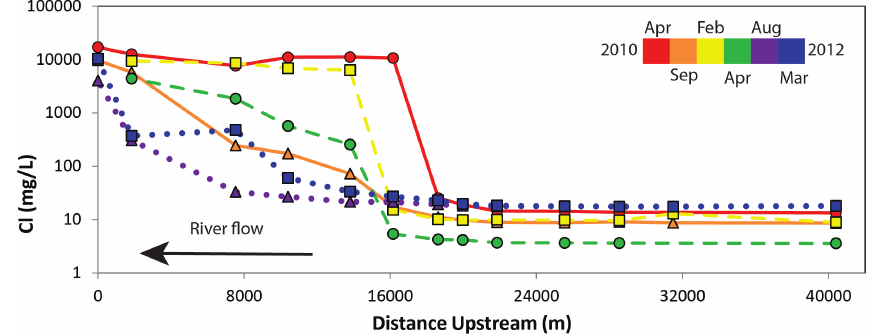
Fig. 6. Distribution of Cl concentrations in water sampled from the Tambo River over the study period. April 2010=solid line with cir- cles, September 2010=solid line with triangles, February 2011=dashed line with squares, April 2011=dashed lines with circles, Au- gust 2011=dotted line with triangles, March 2012=dotted line with